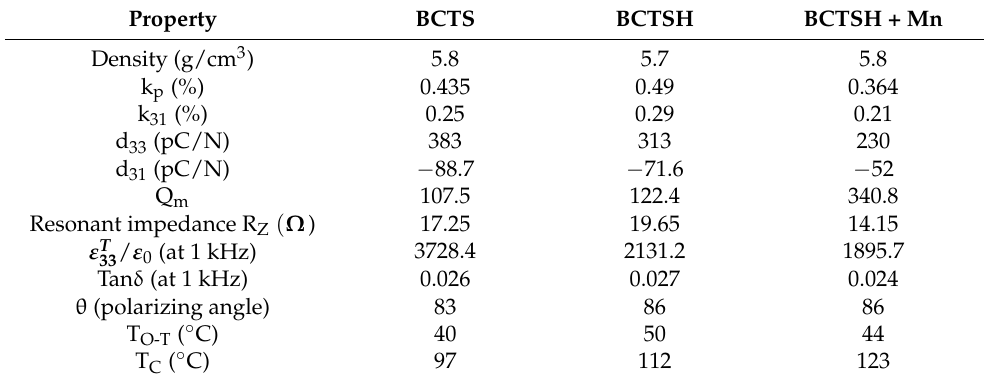
Table 1. The material properties of BCTS, BCTSH and BCTSH + Mn ceramics.